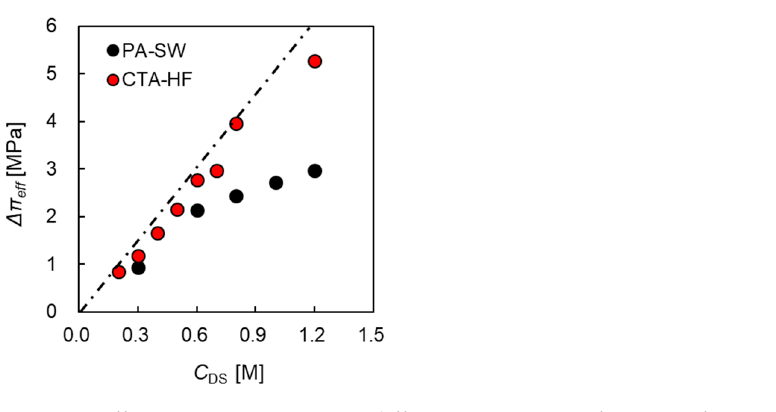
Figure 9. Effective osmotic pressure difference, ∆ π eff , as a function of DS concentration, C DS. FS: treated tap water. Q DS : 10.0 L/min. Q FS : 5.0 L/min.